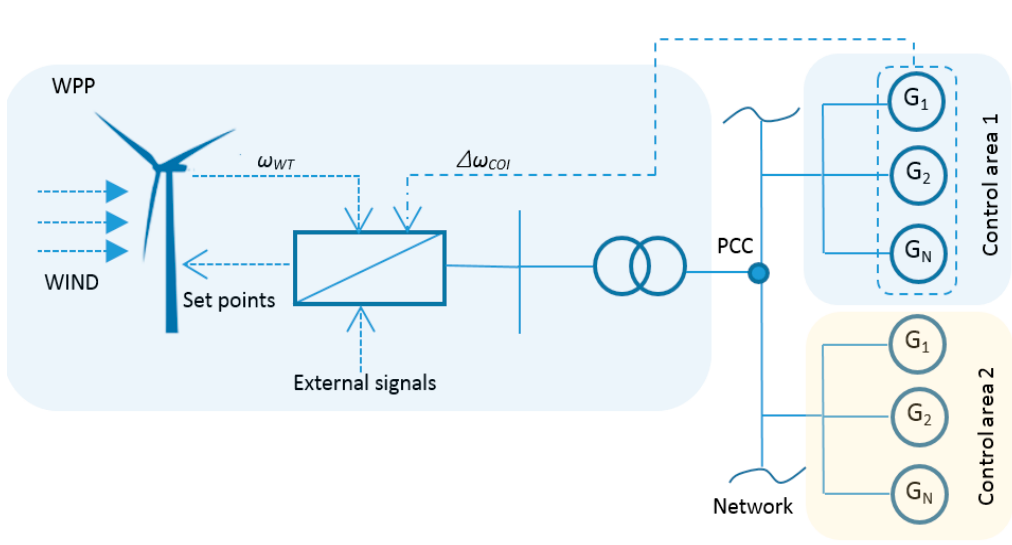
Figure 3. Frequency of center of inertia (FCOI) wind inertia control scheme.